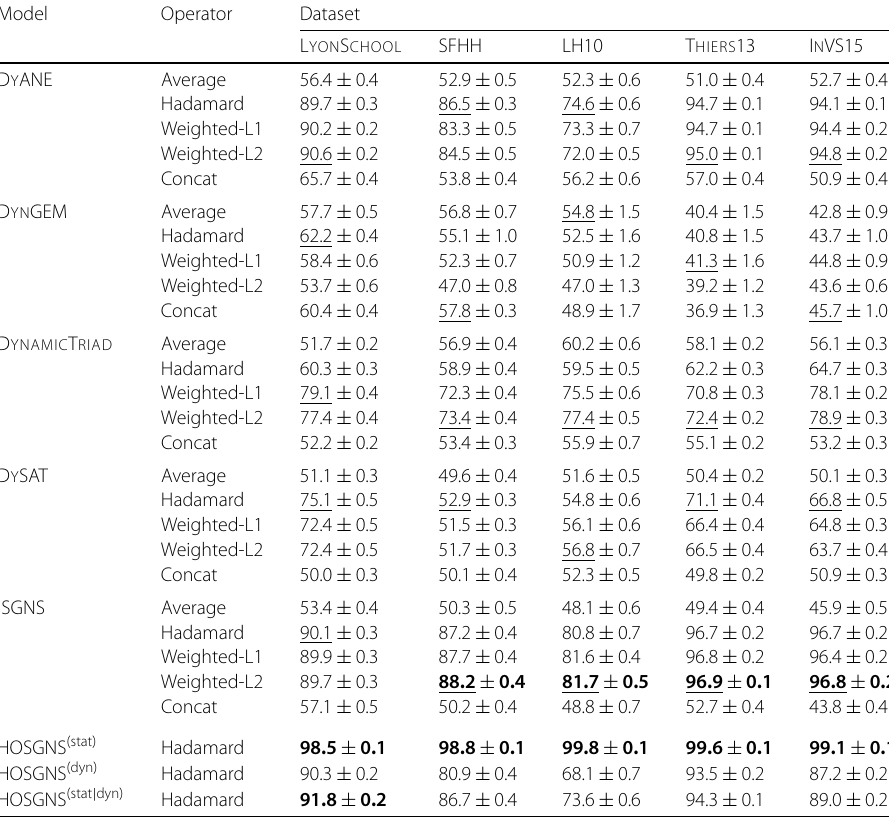
Table 3 Macro-F1 scores for temporal event reconstruction in empirical datasets. We highlight in bold the two best scores for each dataset. For baseline models we underline their highest score